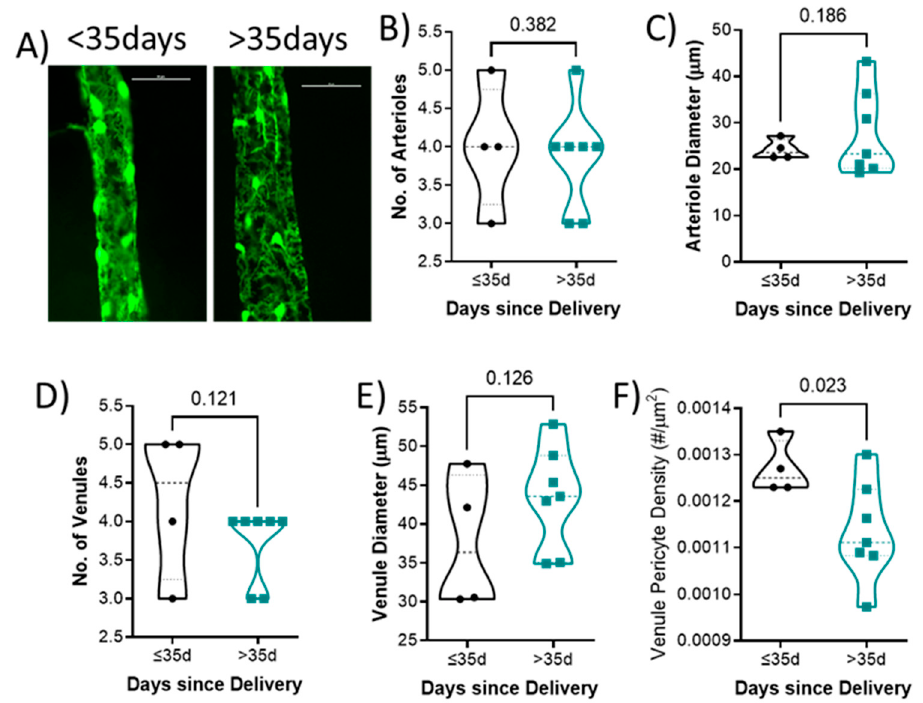
Figure 3. Quantification of retinal vascular parameters segregated by days since delivery. ( A ) Representative images of the retinal mounts from each group. Scale bar represents 50 µm. ( B ) Number of primary arterioles, ( C ) arteriolar diameter, ( D ) number of primary venules, and ( E ) diameter of venules, ( F ) venule pericyte density. Mean values from 1–2 retinal mounts per mouse are shown by individual points. Thick dashed line represents the median. p -values are indicated for each comparison. n = 6–11 per group. Data were analyzed using unpaired t -test.